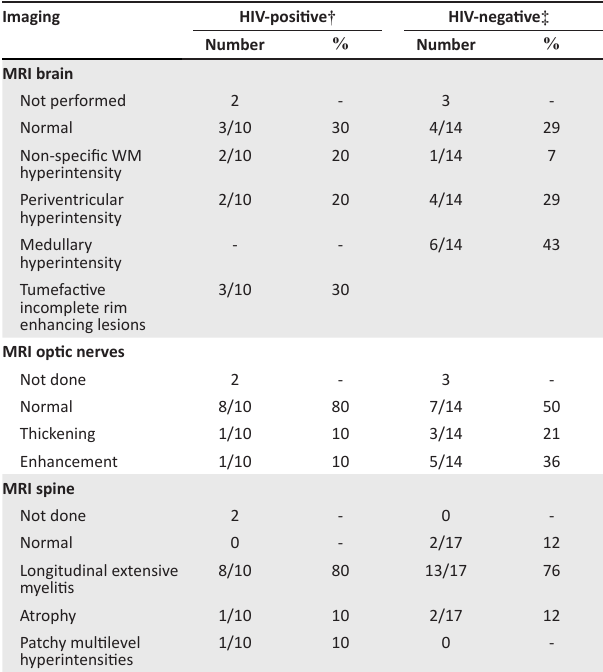
TABLE 3: Neuro-imaging findings.